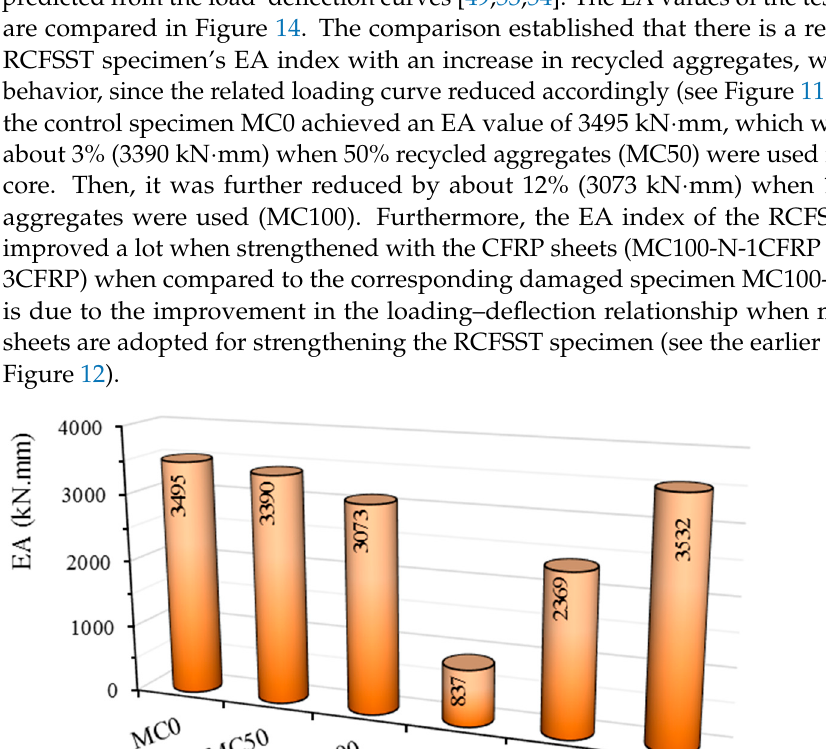
Figure 13. Ultimate bending capacities.